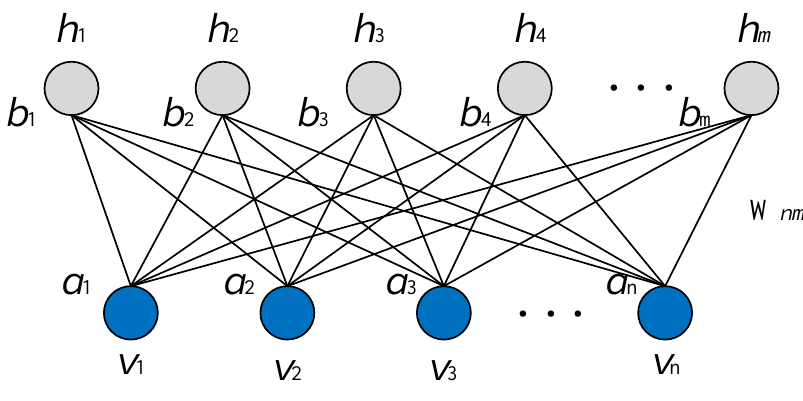
Figure 3. RBM basic structure. RBM is an energy-based model. When the energy is minimum and the network reaches the best state, the construction of the network is actually the process of minimizing the energy function [37]. The definition of RBM energy function is shown in Equation